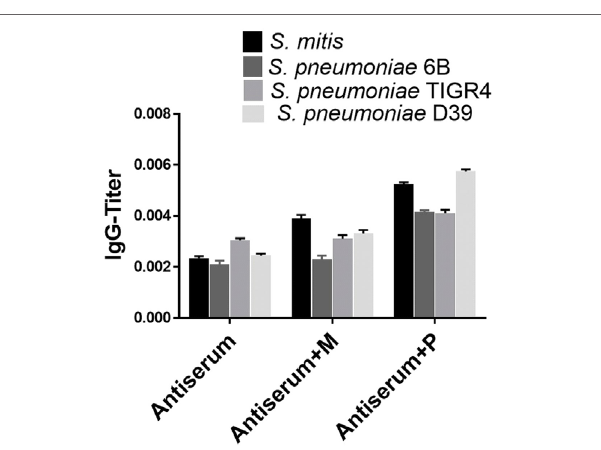
FigUre 3 | Immunoinhibition for IgG cross-reactivity between Streptococcus mitis and Streptococcus pneumoniae . For SDS-PAGE, wells were loaded with 50 µg of protein from S. mitis CCUG31611 and S. pneumoniae strains. After blotting, untreated rabbit S. mitis antiserum or the same antiserum pre-incubated with immobilized S. mitis or S. pneumoniae 6B lysates were used to detect immunoreactivity. Levels of S. mitis or S. pneumoniae -reactive IgG antibodies in the same antiserum preparations. The levels of IgG antibodies were determined using whole-cell ELISA. The OD values were converted to titers, with a cutoff of OD value of 0.40 (see legend to Figure 2 ). The bars show averages of two